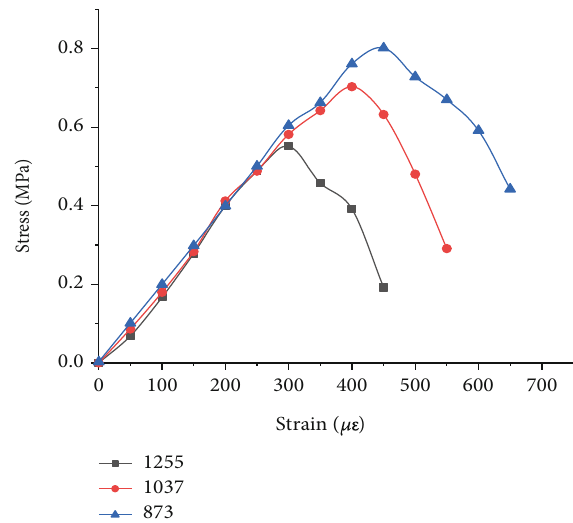
Figure 4: Strain gauge calibration